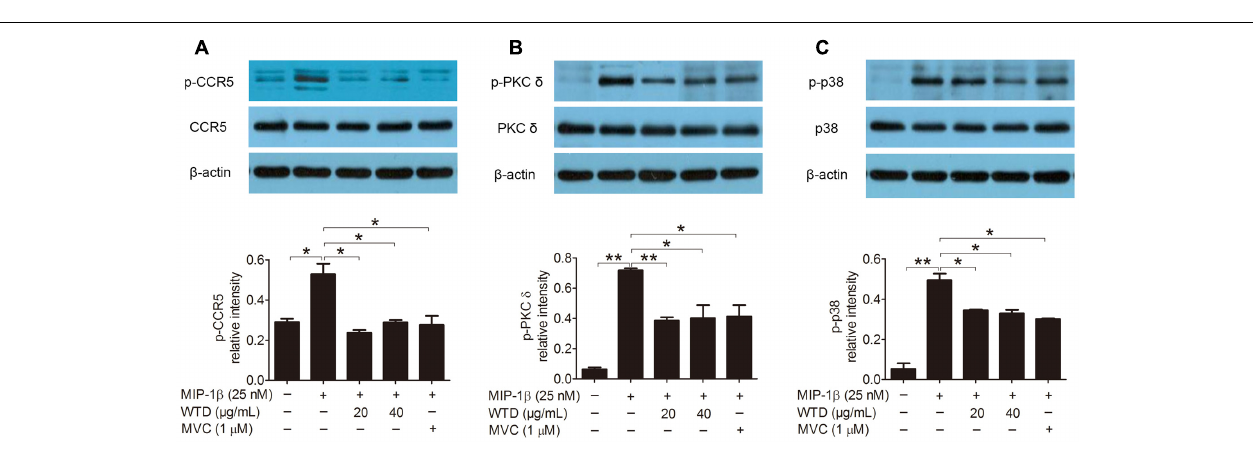
anti-p-PKC δ , anti-p-p38 antibody at 1:1000 and anti-CCR5, anti-PKC δ at 1:5000, anti-p38 (Abcam, Cambridge, UK) at 1:4,000 in TBST containing 3% bovine sera albumin. After